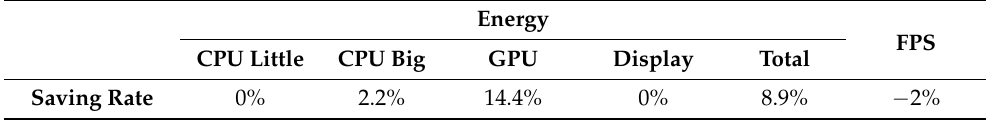
Figure 2. Workloads classified by normalized cost in HiCAP. Table 3. Comparisons of power saving and FPS of interactive governors classifying workloads by phase over normalized cost.